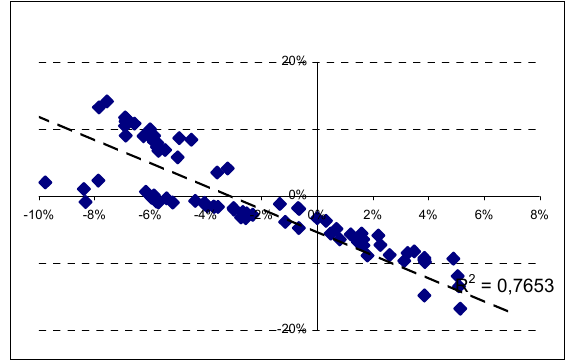
Figure 3: Anglo: ROI(BP-IB) vs Implied Vol